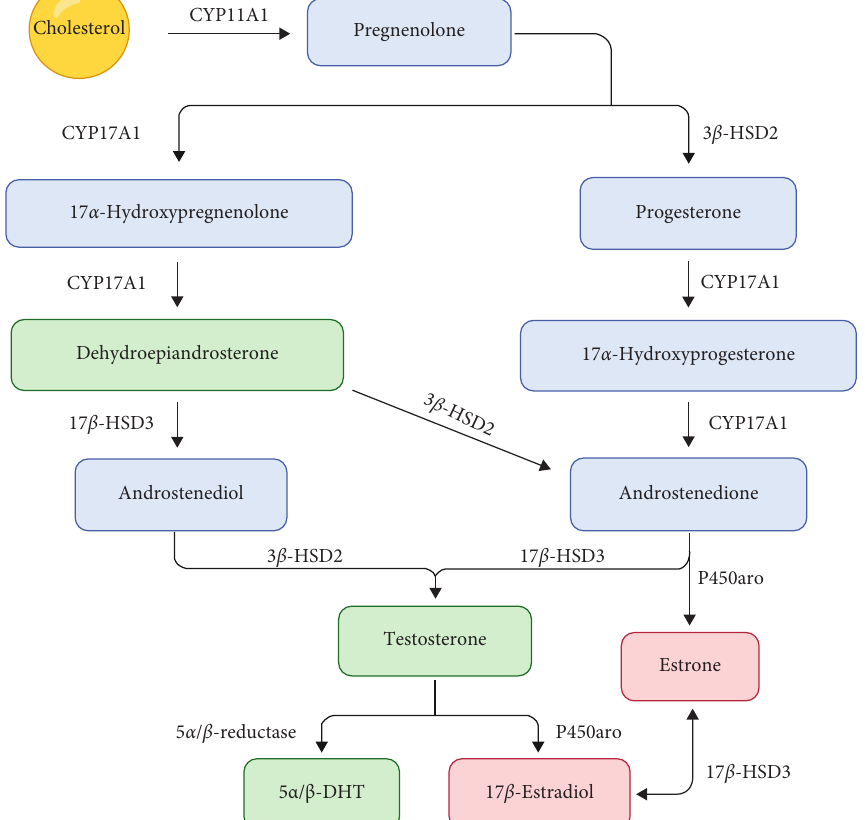
Figure 1: Androgen synthesis from cholesterol. Steroidogenesis in males is carried out mainly by Leydig cells and in females by theca and granulosa cells. Cholesterol is the precursor of all sex steroids, and its conversion to pregnenolone is mediated by the cholesterol side-chain cleavage cytochrome P450 enzyme (CYP11A1/P450scc). Once formed, this progestogen is converted into progesterone by 3 β -hydrox- ysteroid dehydrogenase (3 β -HSD2). Then, 17 α -hydroxylase/17,20 lyase (CYP17A1/P450c17) hydroxylates pregnenolone to produce 17 α - hydroxypregnenolone and subsequently removes the acetyl group to form dehydroepiandrosterone (DHEA). This last product can be either converted into androstenedione via 3 β -HSD2 or into androstenediol by 17 β -hydroxysteroid dehydrogenase (17 β -HSD3). Androstenedione and androstenediol are further biotransformed to testosterone by 17 β -HSD3 and 3 β -HSD2, respectively. Furthermore, testosterone can be reduced to 5 α - or 5 β -dihydrotestosterone (5- α / β -DHT) by 5- α / β -reductases. Furthermore, P450 aromatase (P450aro) may convert tes- tosterone into 17 β -estradiol and androstenedione into estrone. Finally, 17 β -HSD3 catalyzes the formation of 17 β -estradiol from